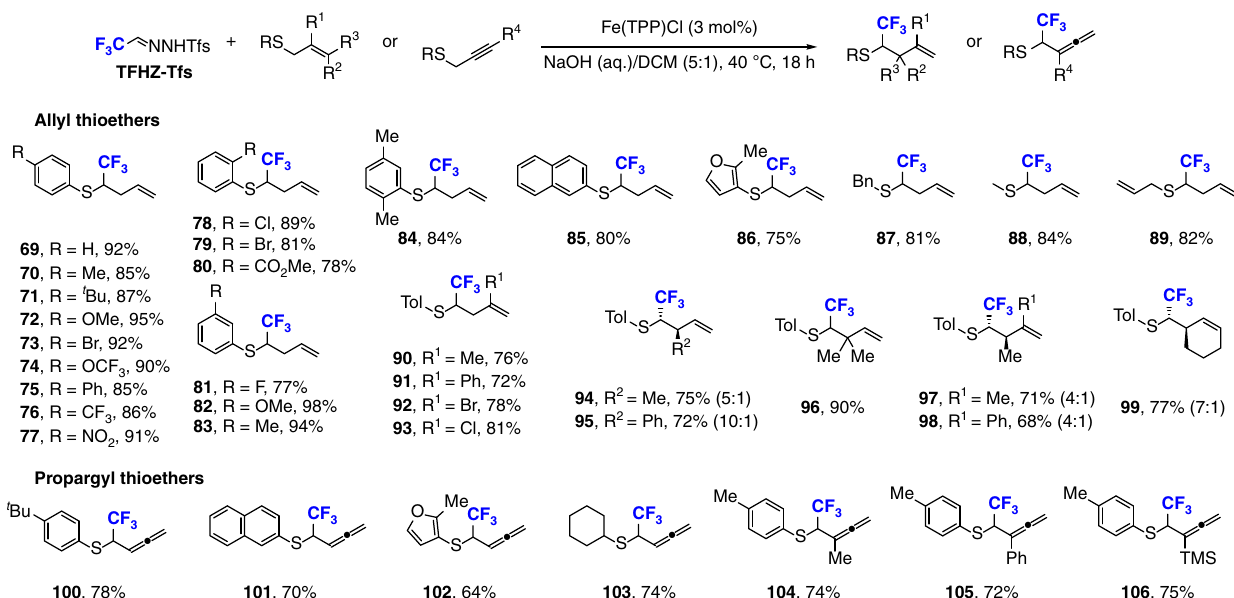
Fig. 7 Scope of Doyle – Kirmse reaction. Reaction conditions: thioether (0.3 mmol), TFHZ-Tfs (0.6 mmol), FeTPPCl (3 mol%), NaOH (aq.)/DCM (5:1), 40 °C, 18